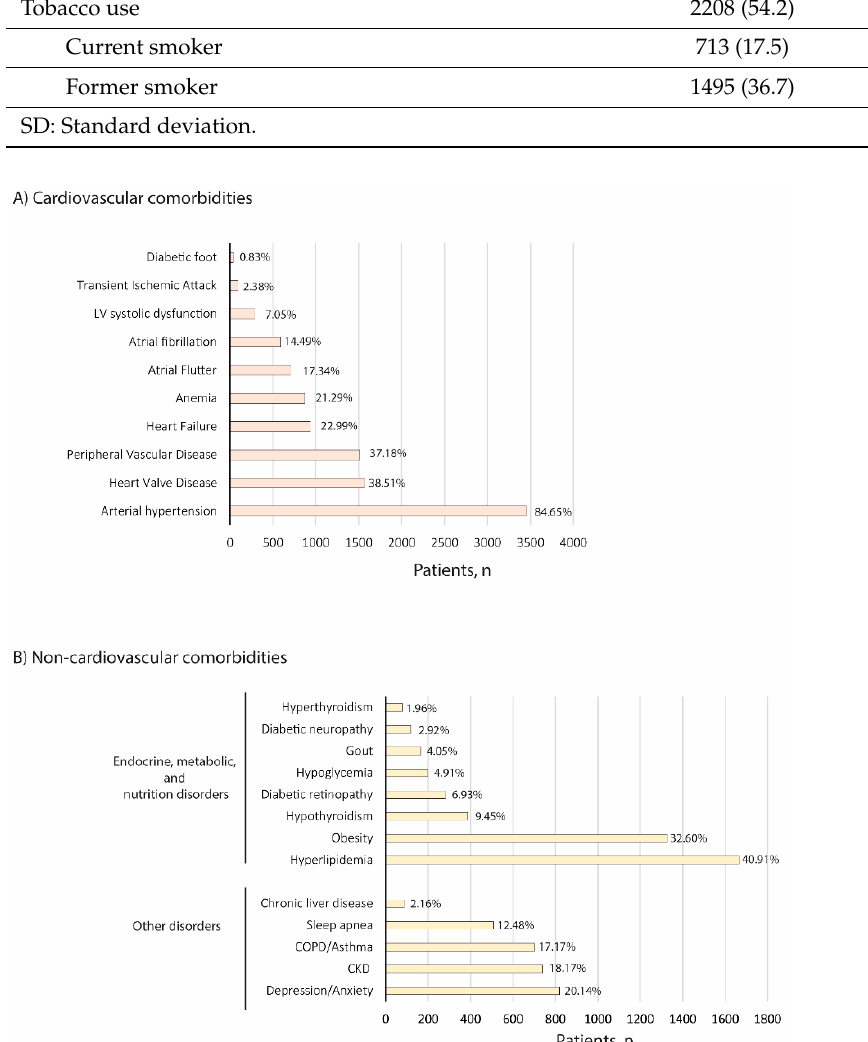
Figure 1. Comorbidities of the study population at index. ( A ) Cardiovascular and ( B ) non- cardiovascular comorbidities are shown. CKD: Chronic kidney disease; COPD: Chronic obstructive pulmonary disease.